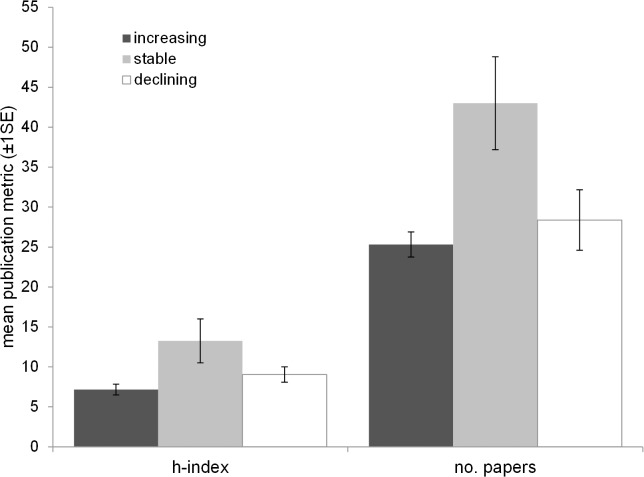
Mean publication metrics (± 1SE) in relation to changing bird distributions over the last 20 years.Species which have had stable distributions over this period have significantly higher metrics than increasing or declining species combined (no. papers: Kruskal Wallis χ2 = 8.71, p<0.005; h index: χ2 = 10.66, p<0.005).